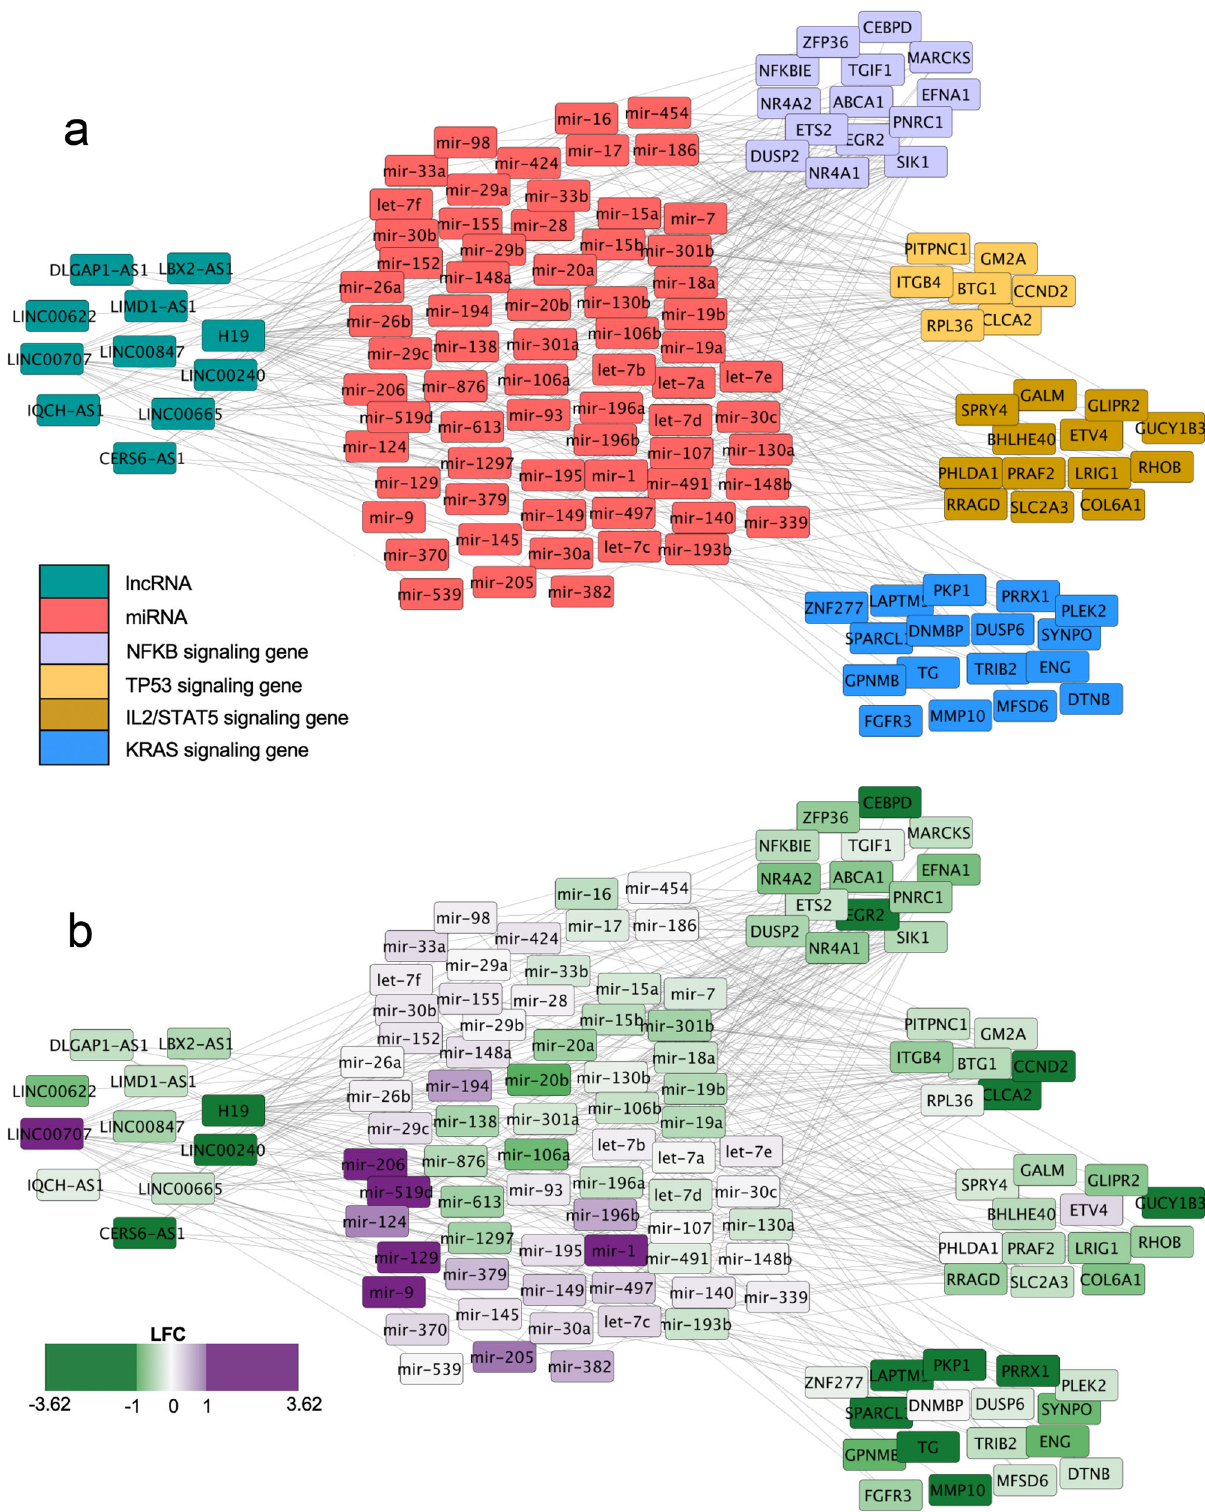
Fig. 4 Dysregulation of lncRNA-miRNA regulatory network causes downregulation of key cancer driver pathways in tumor-derived cell lines. a Types of genes are identi fi ed by color and positioning in the Cytoscape graph. Gene interactions from miRNet databases are denoted by gray lines. lncRNA are on the left, miRNA in the center, and differentially expressed protein-coding genes from each of the four cancer driver pathways are on the right side of the graph. b Positive LFC (purple) denotes higher expression in CCLE. Negative LFC (green) denotes higher expression in TCGA.